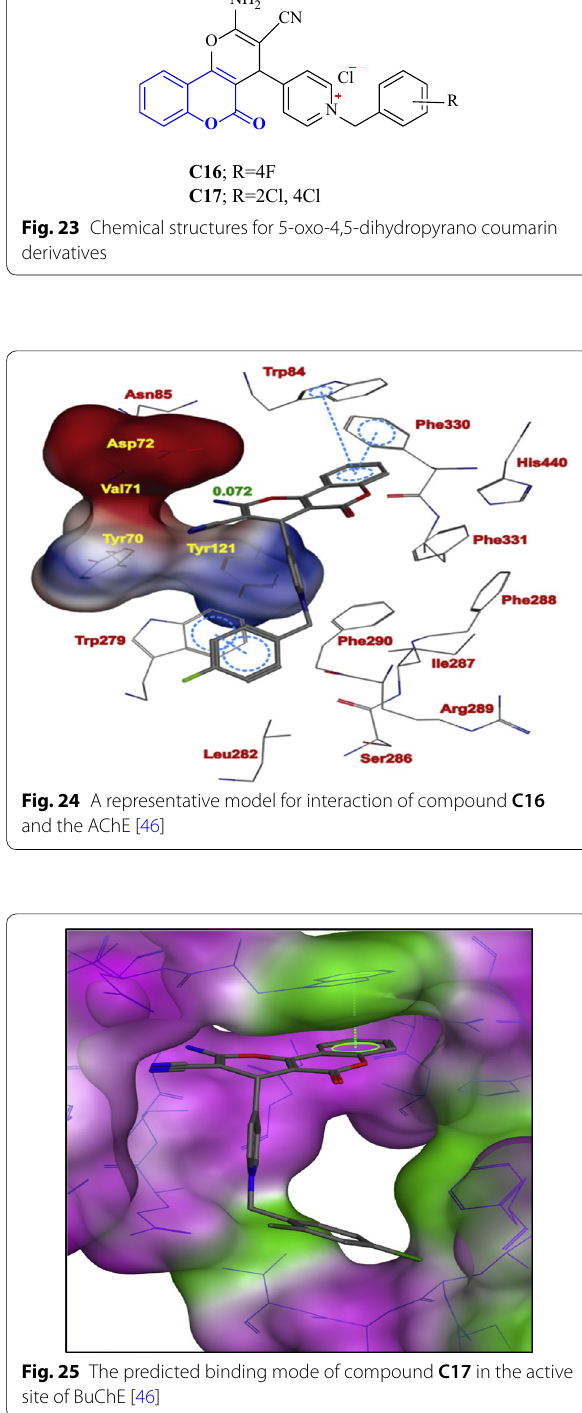
(Fig. 30). Compound C31 was specifically the most potent AChE inhibitor with IC 50 0.003 μM and C22 was the most potent inhibitor of BuChE with IC 50 11.32 μM.